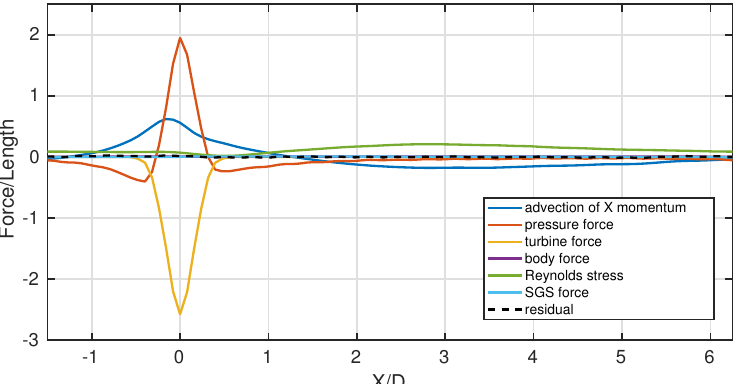
Figure 4. Streamwise momentum equation terms integrated over the streamtube cross-section for = 1.33. Each term is normalized by the total turbine force, such that the integral of the turbine C (cid:48) T force curve is − 1. X / D = 0 is the location of the actuator disk, and the x-axis extends the length of the separation between turbine rows. The residual is the sum of all other terms.